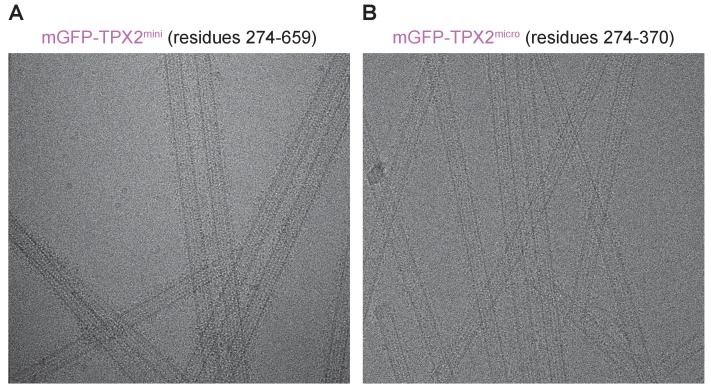
Cryo-EM images of GMPCPP-MTs decorated with TPX2mini or TPX2micro constructs.Cryo-EM images of GMPCPP-MTs in the presence of saturating amounts of either mGFP-TPX2mini (A) or mGFP-TPX2micro (B) clearly show extra densities on the MT surface corresponding to the TPX2 molecules.